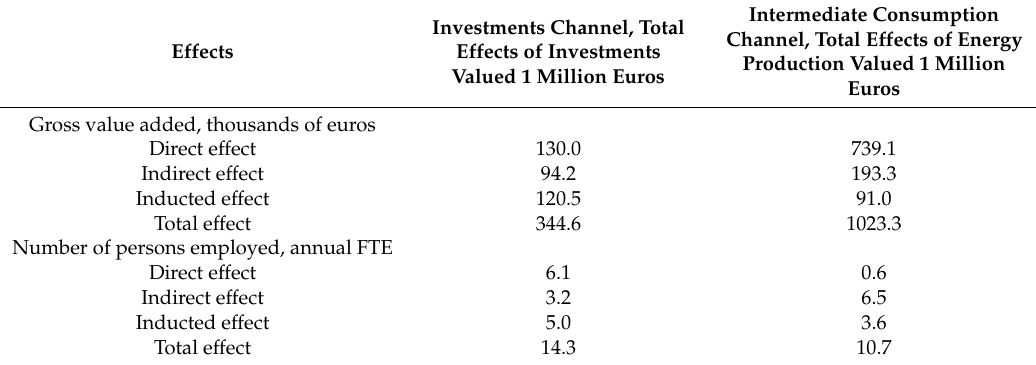
Table 3. Spillover of direct, indirect, and induced GVA and employment effects in investment and intermediate consumption